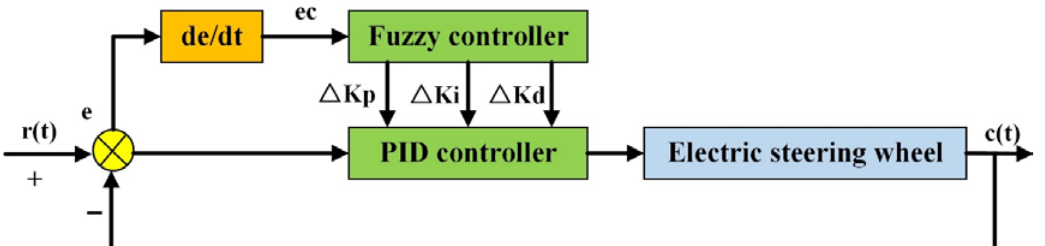
Figure 10. Fuzzy PID controller schematic.